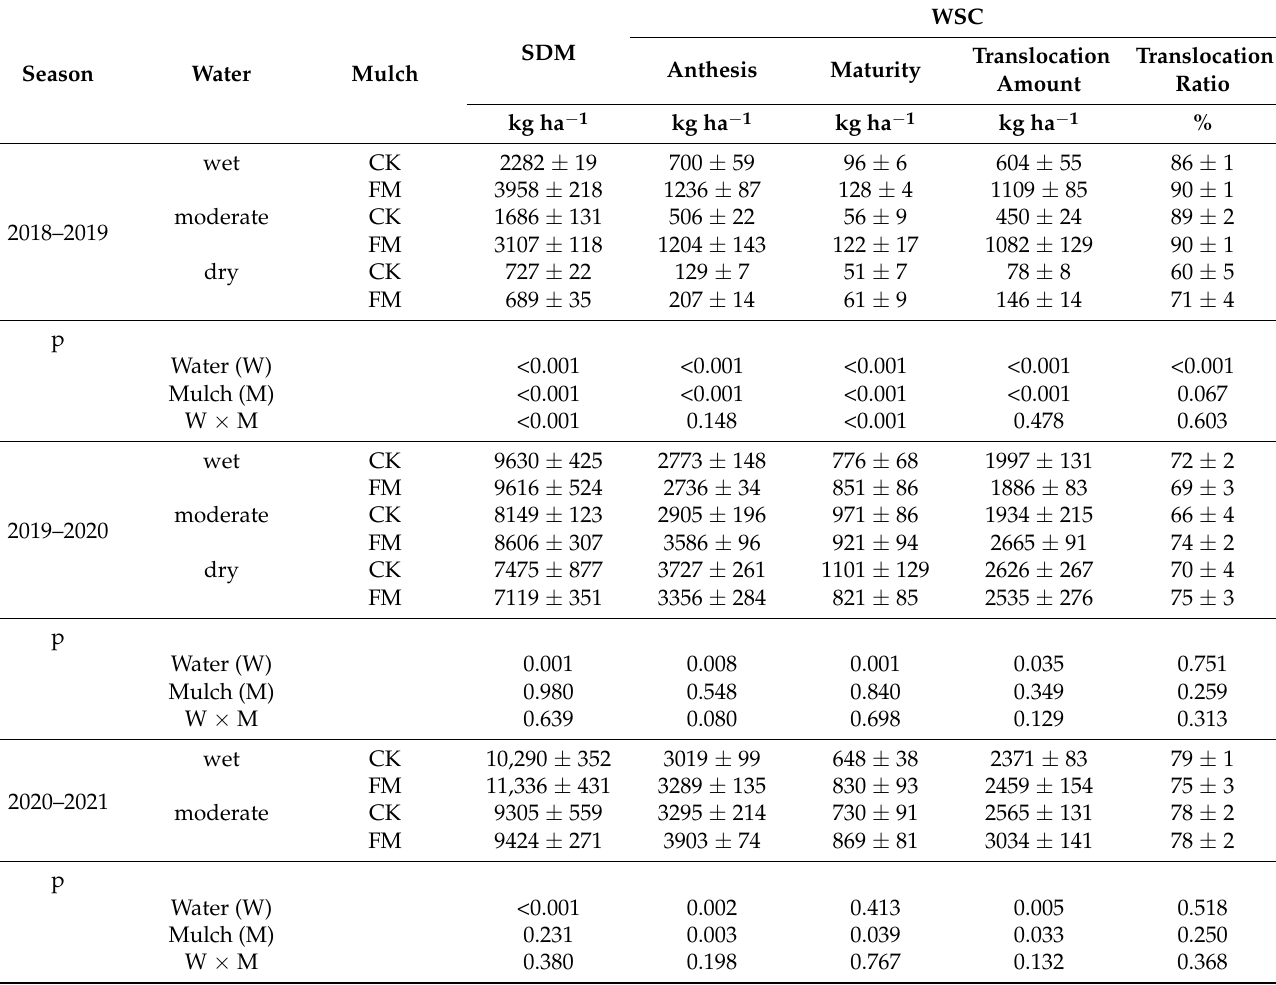
Table 2. Structural dry matter at anthesis (SDM), water-soluble carbohydrates (WSC) content at anthesis and maturity, and apparent translocation (amount and ratio) in a factorial study combined initial soil water (wet, moderate, dry) with mulch (CK, bare ground control; FM, plastic film mulching). Mean and standard errors of four replicates are presented for 2018–2019 and 2019–2020. In 2020–2021, high rainfall during fallow precluded the dry treatment, and results are for moderate ( n = 4) and wet ( n = 8) treatments only. p is from the ANOVA testing effect of water (W), mulch (M), and their